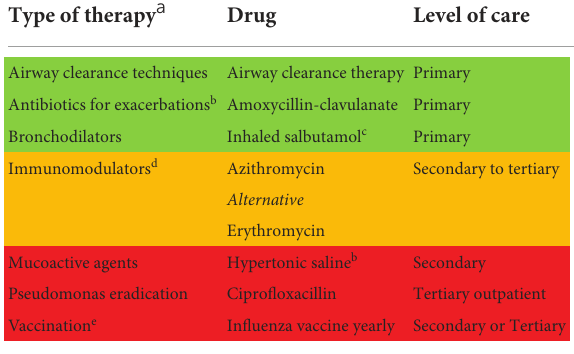
TABLE 1 Management of bronchiectasis in